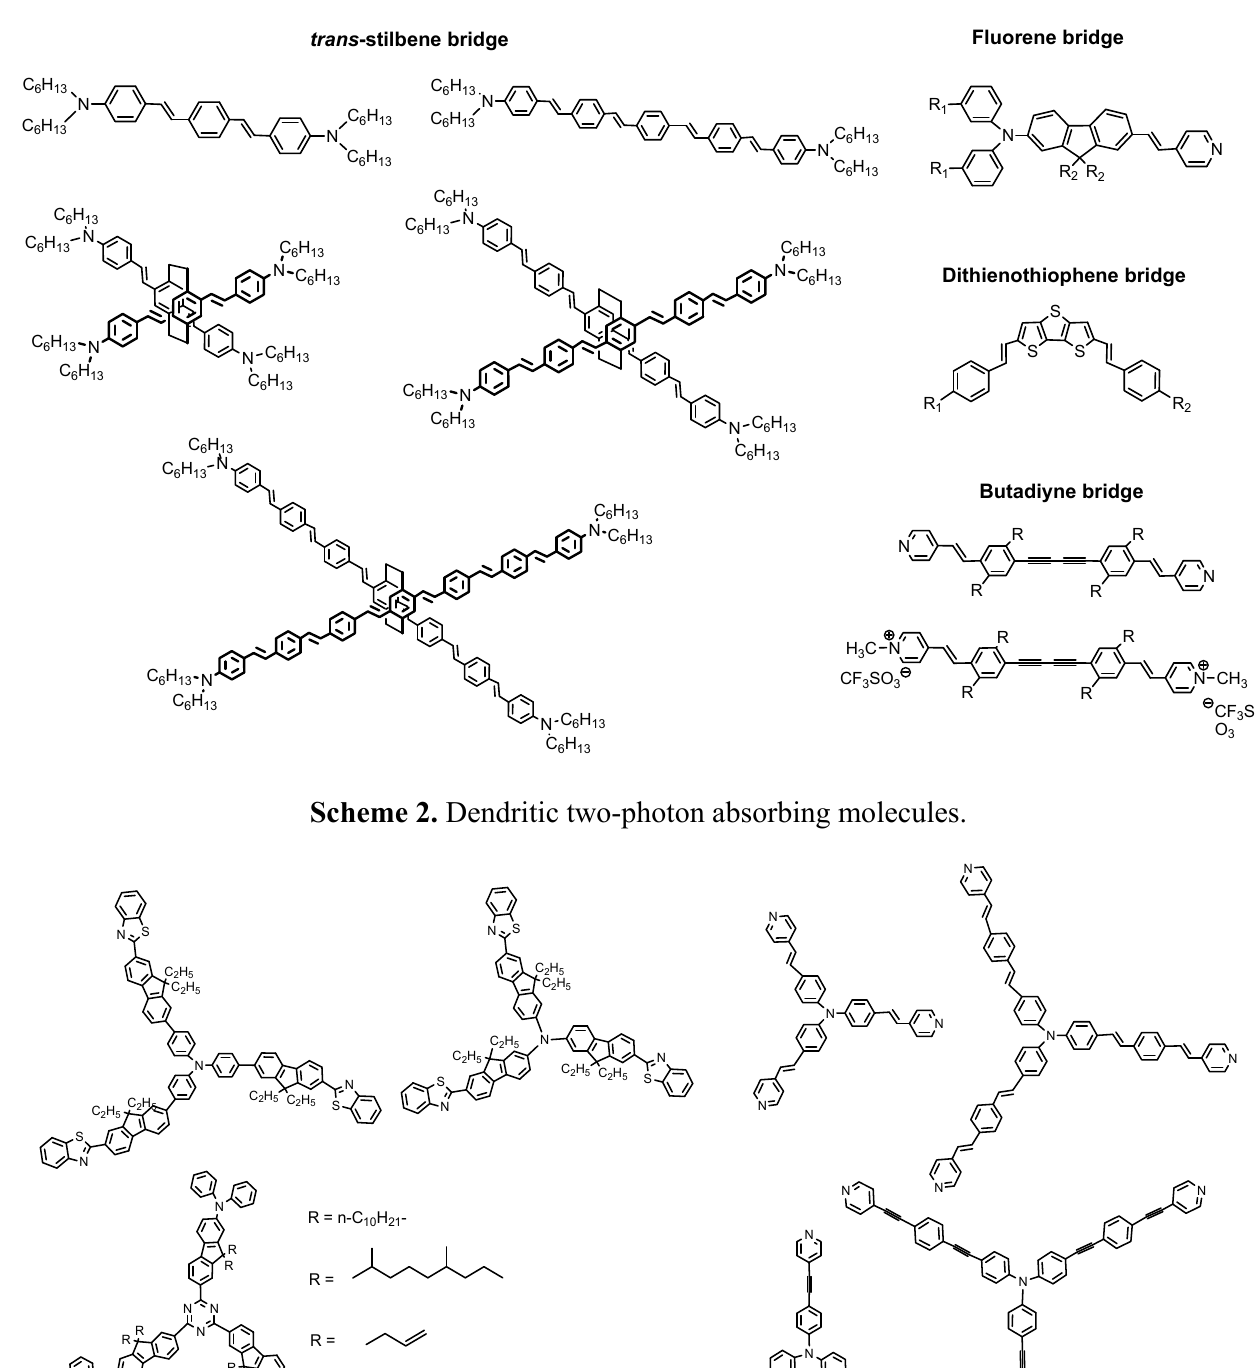
Scheme 1. Two-photon absorbing molecules.